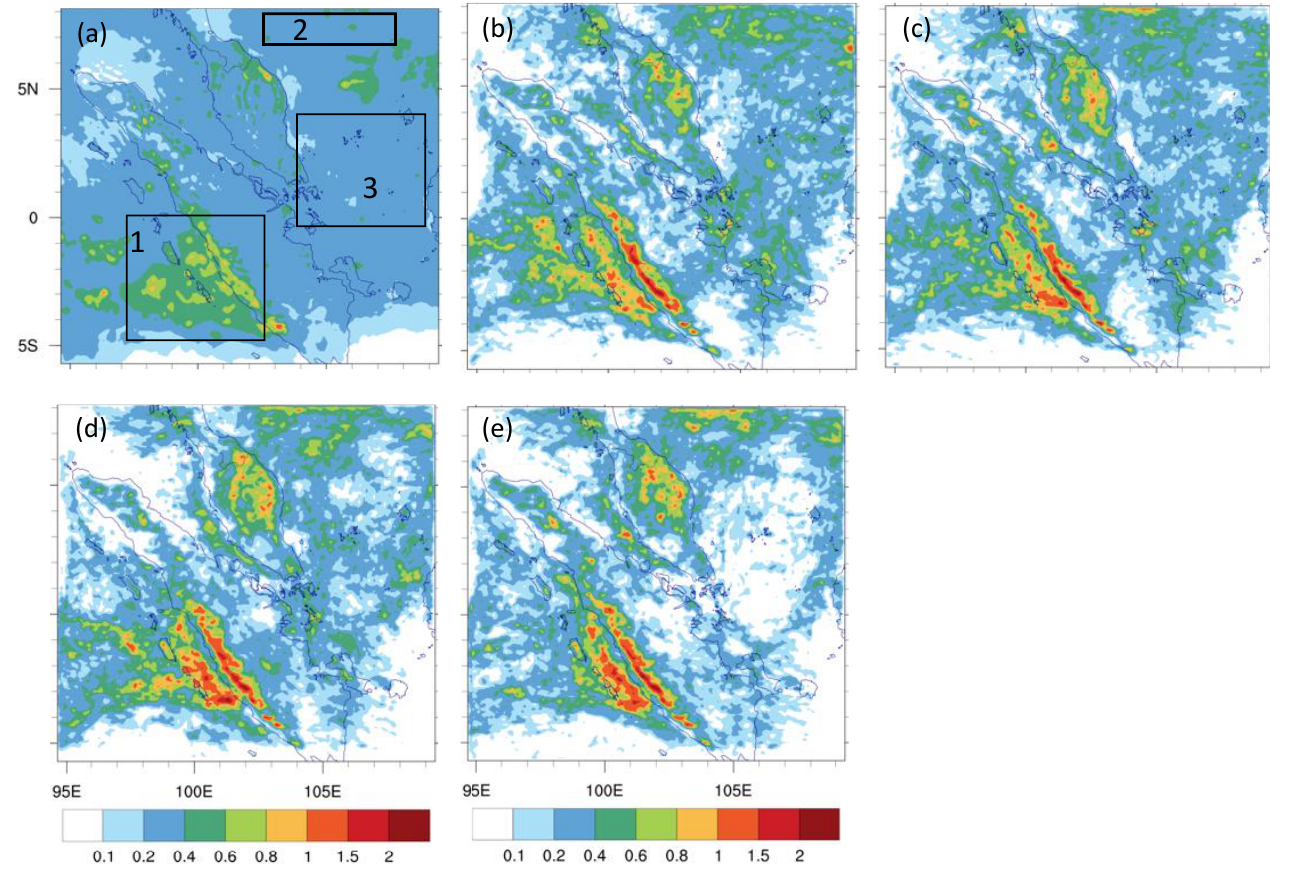
Figure 5. Monthly (June 2019) mean rainfall in millimeters per hour from: ( a ) ECMWF, ( b ) CTRL, ( c ) EXPT_uv, ( d ) EXPT_uvT, and ( e ) EXPT_uvTQ. CTRL and experiments are regrided to ECMWF resolution. The boxes in ( a ) indicate the regions where experiments show marked differences compared to ECMWF forecast.